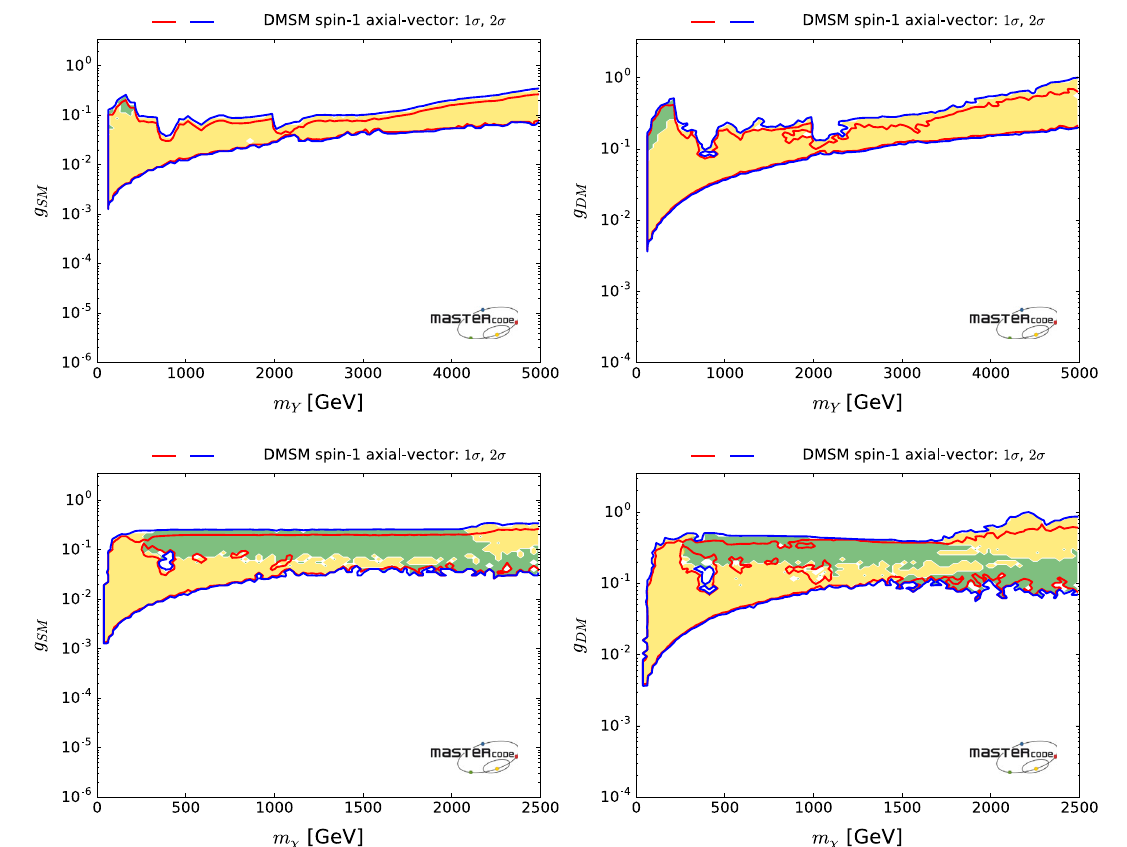
Fig. 15 The likelihood functions for g SM (left panel) and g DM (right panel) as functions of m χ in the model with axial-vector couplings after the selection 1 / 3 < g SM / g DM < 3. We again use colour coding to illustrate the dominant mechanisms bringing the DM density into